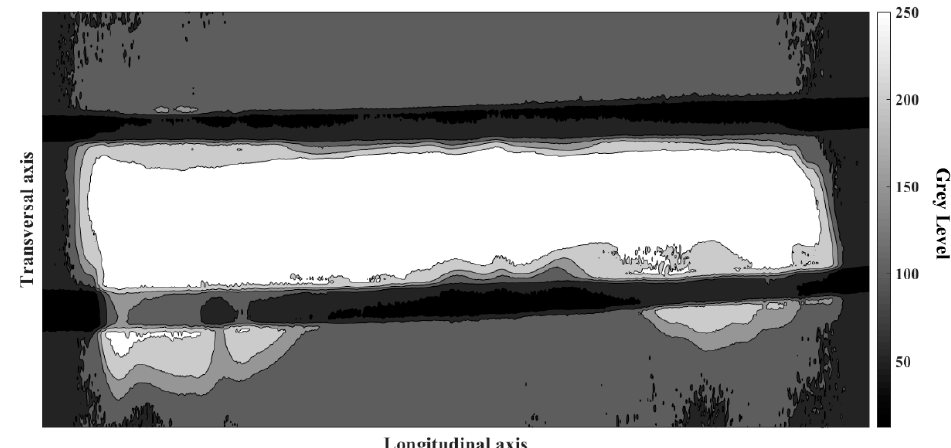
Figure 16. Luminance distribution of the concentrated radiation reflected by a prototype LFR mirror facet into a Lambertian target.